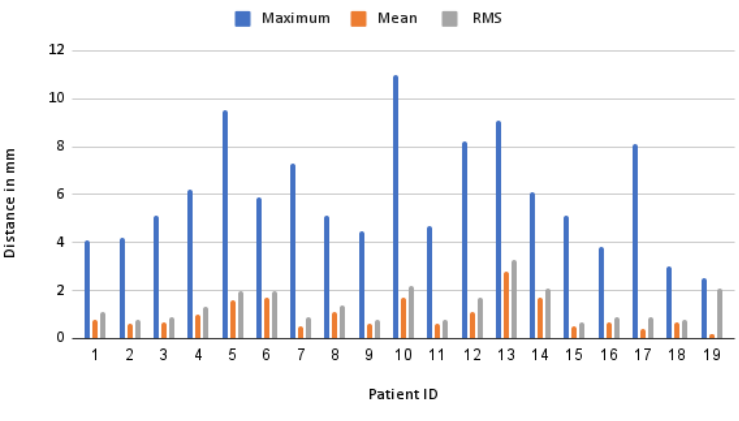
Figure 21. Bar chart of the mean, maximum and RMS error using the Hausdorff distances.